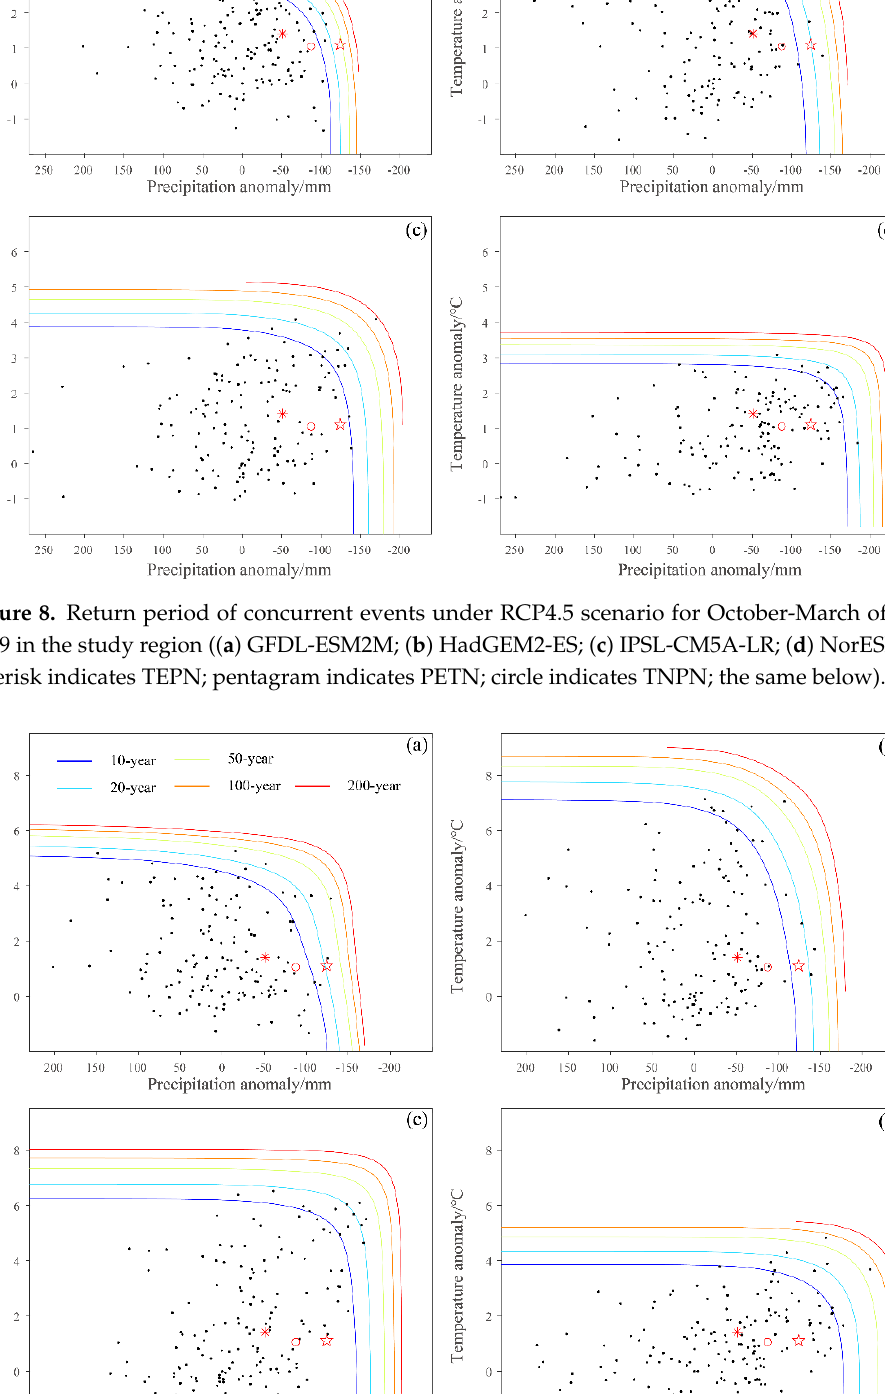
would be around 6 °C higher than that of NorESM1-M by about 5 °C. In both cases, TEPN, PETN and PETN events would become normal events. A significant increase in tempera- ture would result in a return period of only about 20 years for extreme events with a pre- cipitation deficit of about 150 mm (Figure 9c,d).